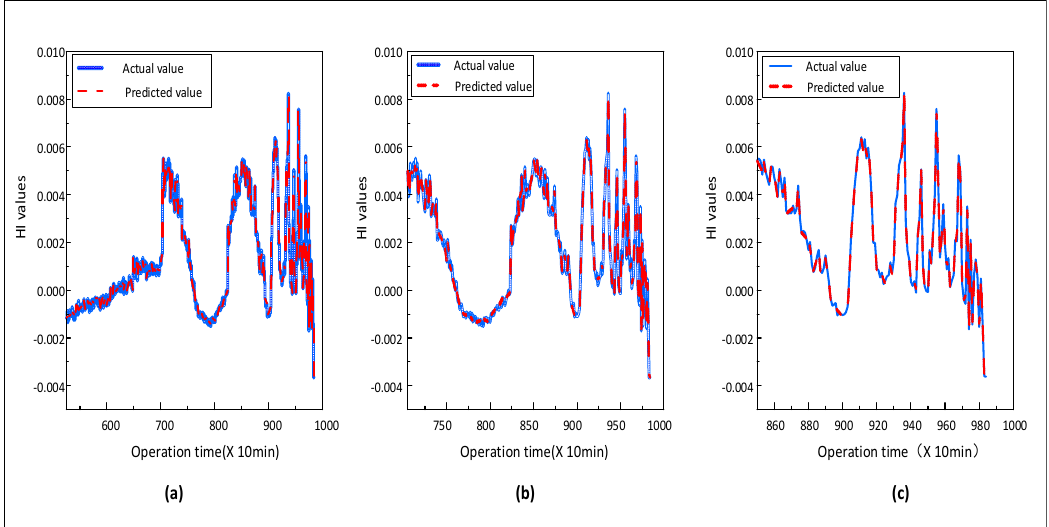
Table 1. Evaluation indexes of different optimizers.